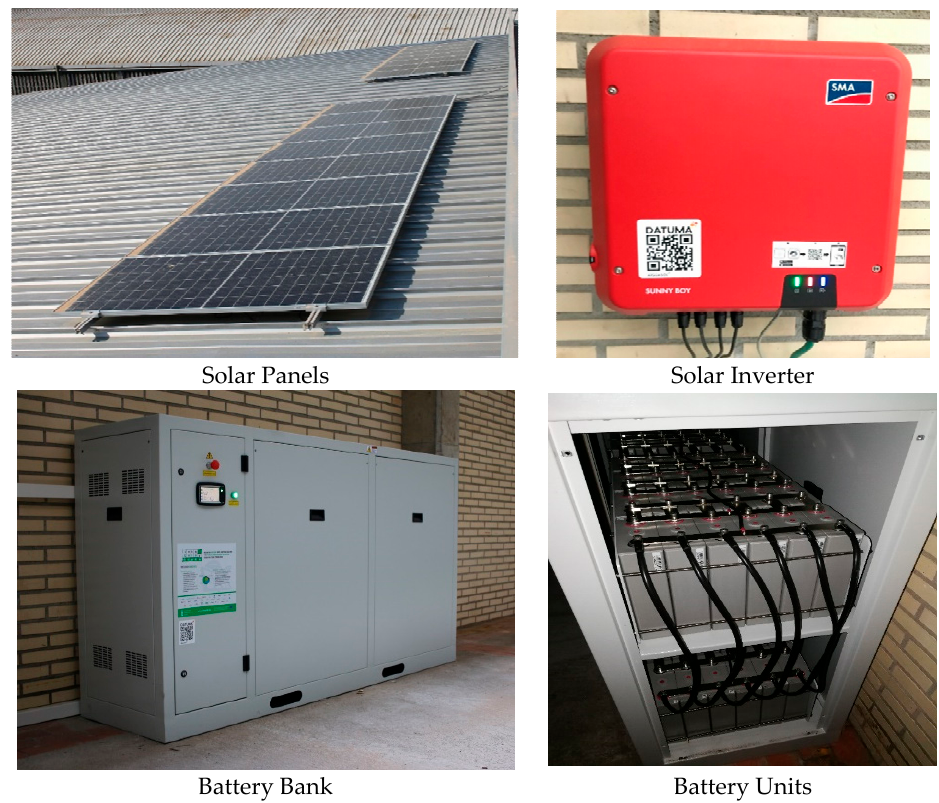
Figure 4. Main components of the BESS . The hardware components added to the energy system of the swimming pool are shown.